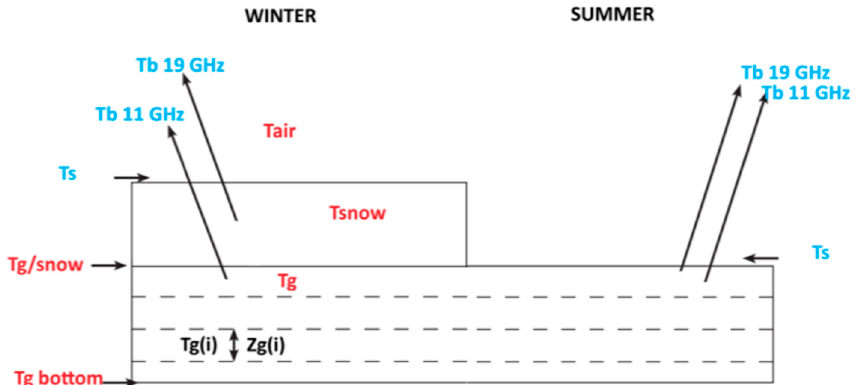
Figure 2. Temperatures used in this study for summer (right) and winter (left) periods. T air is the 2-m air temperature used as a driver (NARR and optimized), T snow is the mean snowpack temperature (simulated by CLASS), Tg(i) is the soil temperature simulated by CLASS at each soil layer (i) of thickness Zg(i), Tg/snow is the soil/snow interface temperature (simulated by CLASS), Tg is the first layer soil temperature (simulated by CLASS and measurements for validation), Tg_bottom is the soil temperature of the last soil layer (fixed), Ts is the land surface temperature (MODIS and simulated by CLASS), and Tb is the microwave brightness temperature at 11 and 19 GHz (AMSR-E and simulated by HUT driven with CLASS outputs).